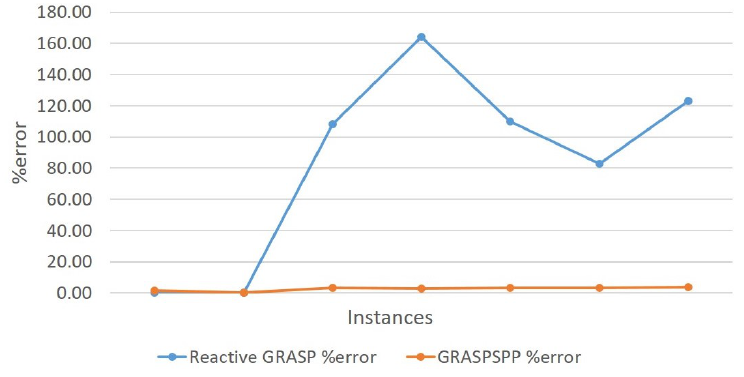
Figure 14. Average error between GRASPSPP and reactive GRASP.